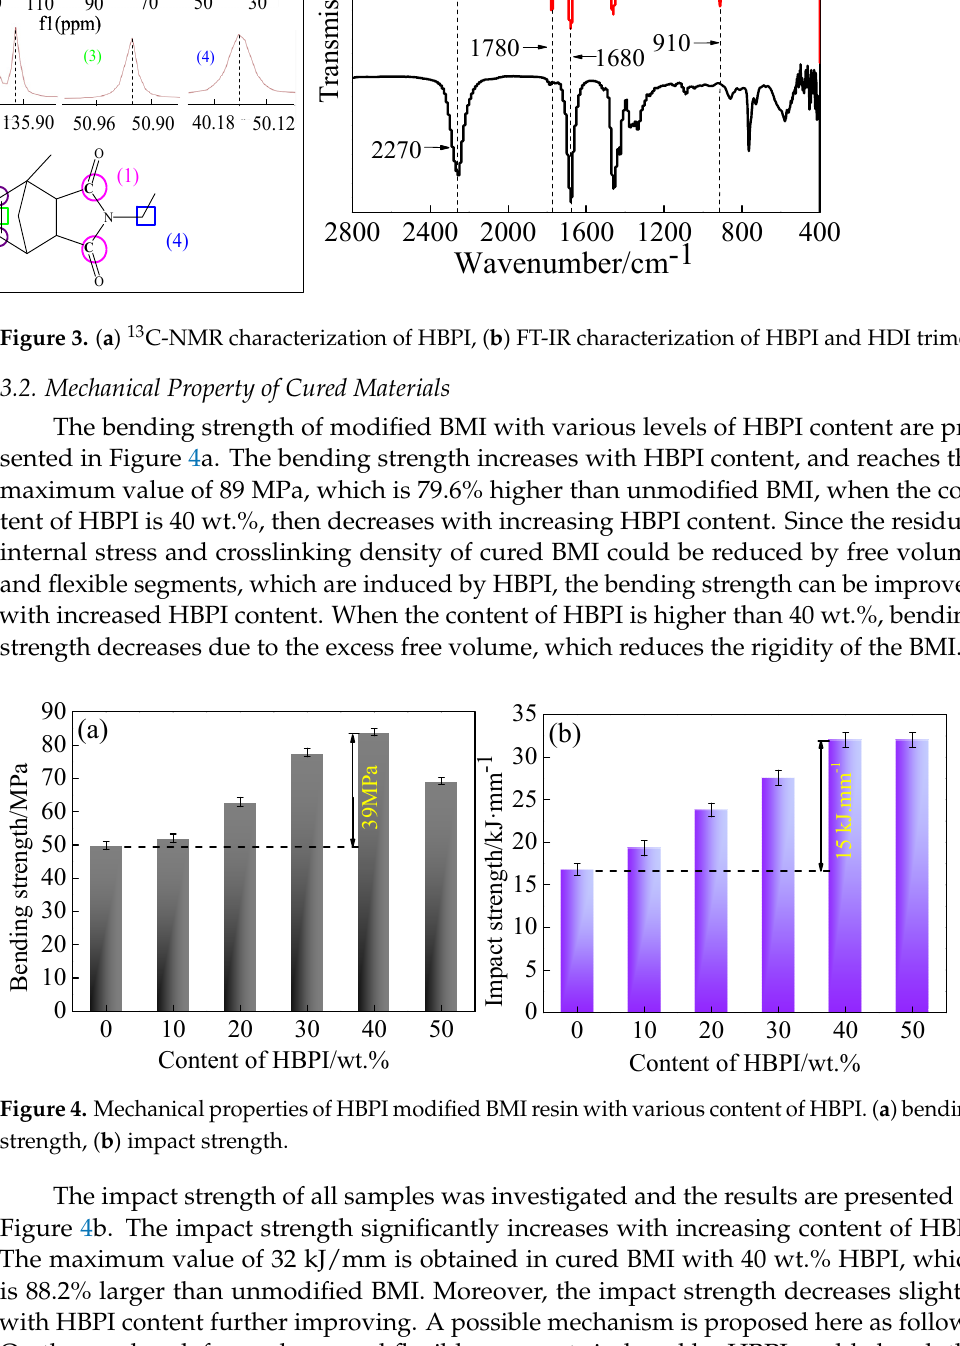
(b) Figure 5. ( a ) Bending modulus of HBPI modified BMI resin with different content of HBPI, ( b ) Com- parison of modified BMI with 20 wt.% of HBPI and previous investigations.